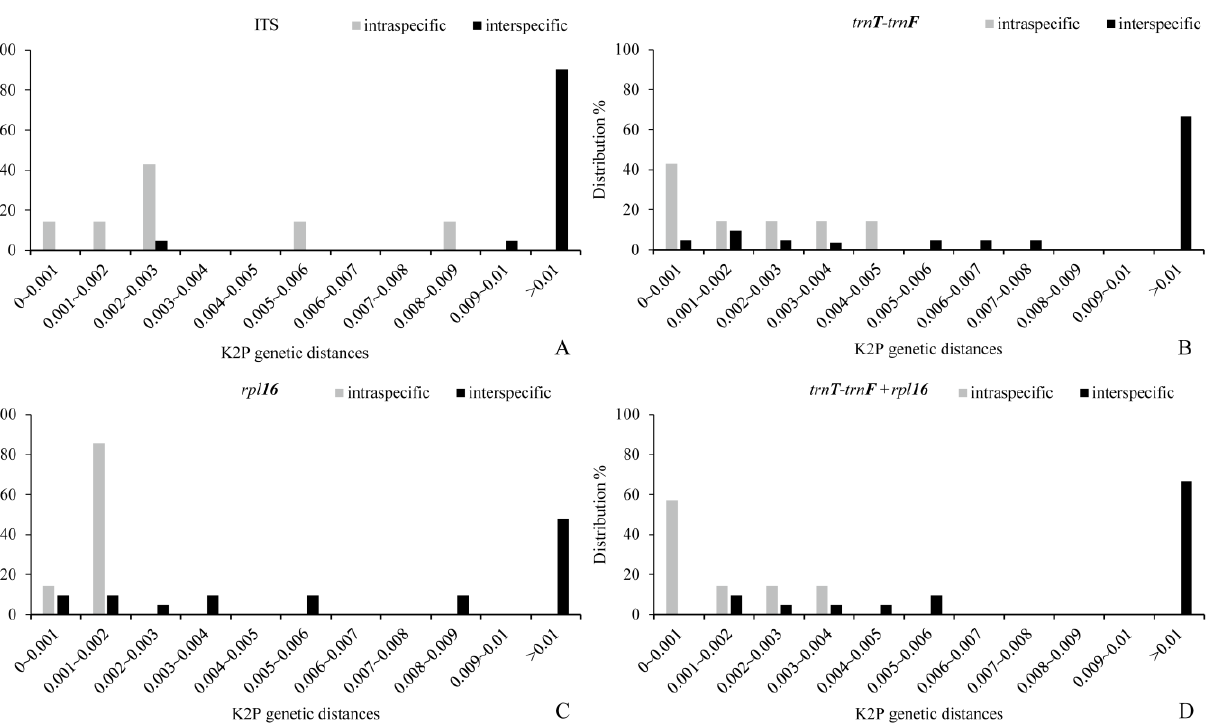
Figure 3. Relative distribution of inter- and intraspecific distances of each sequence of Nymphaea . ( A ) ITS, ( B ) trnT-trnF , ( C ) rpl16 and ( D ) trnT-trnF+rpl16